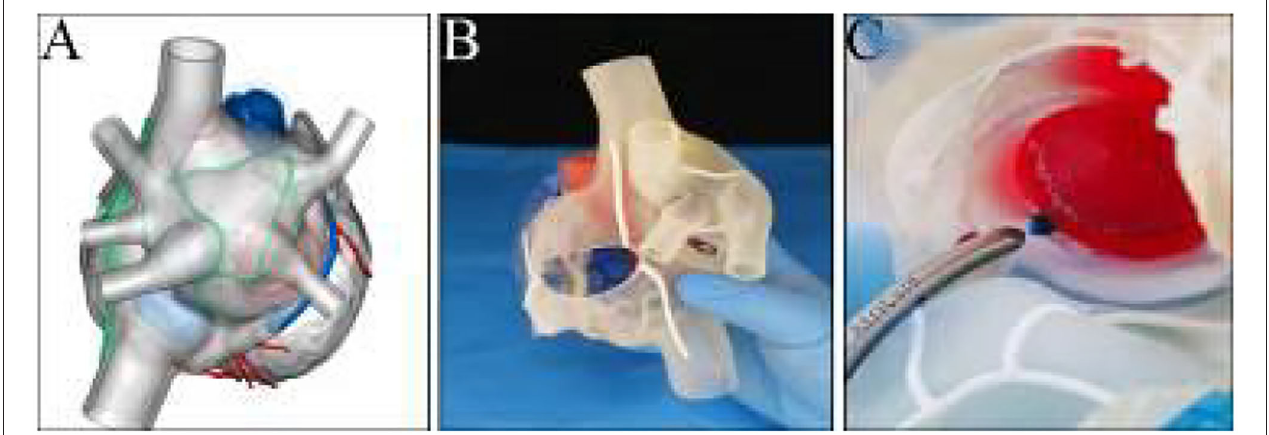
FIGURE 2 | (A) Pre-printing digital file of the 3D model embedded with designated ablation lines. (B) View of the three-dimensional printed model. (C) Clamping on the model of the mitral isthmus line during the rehearsal process.